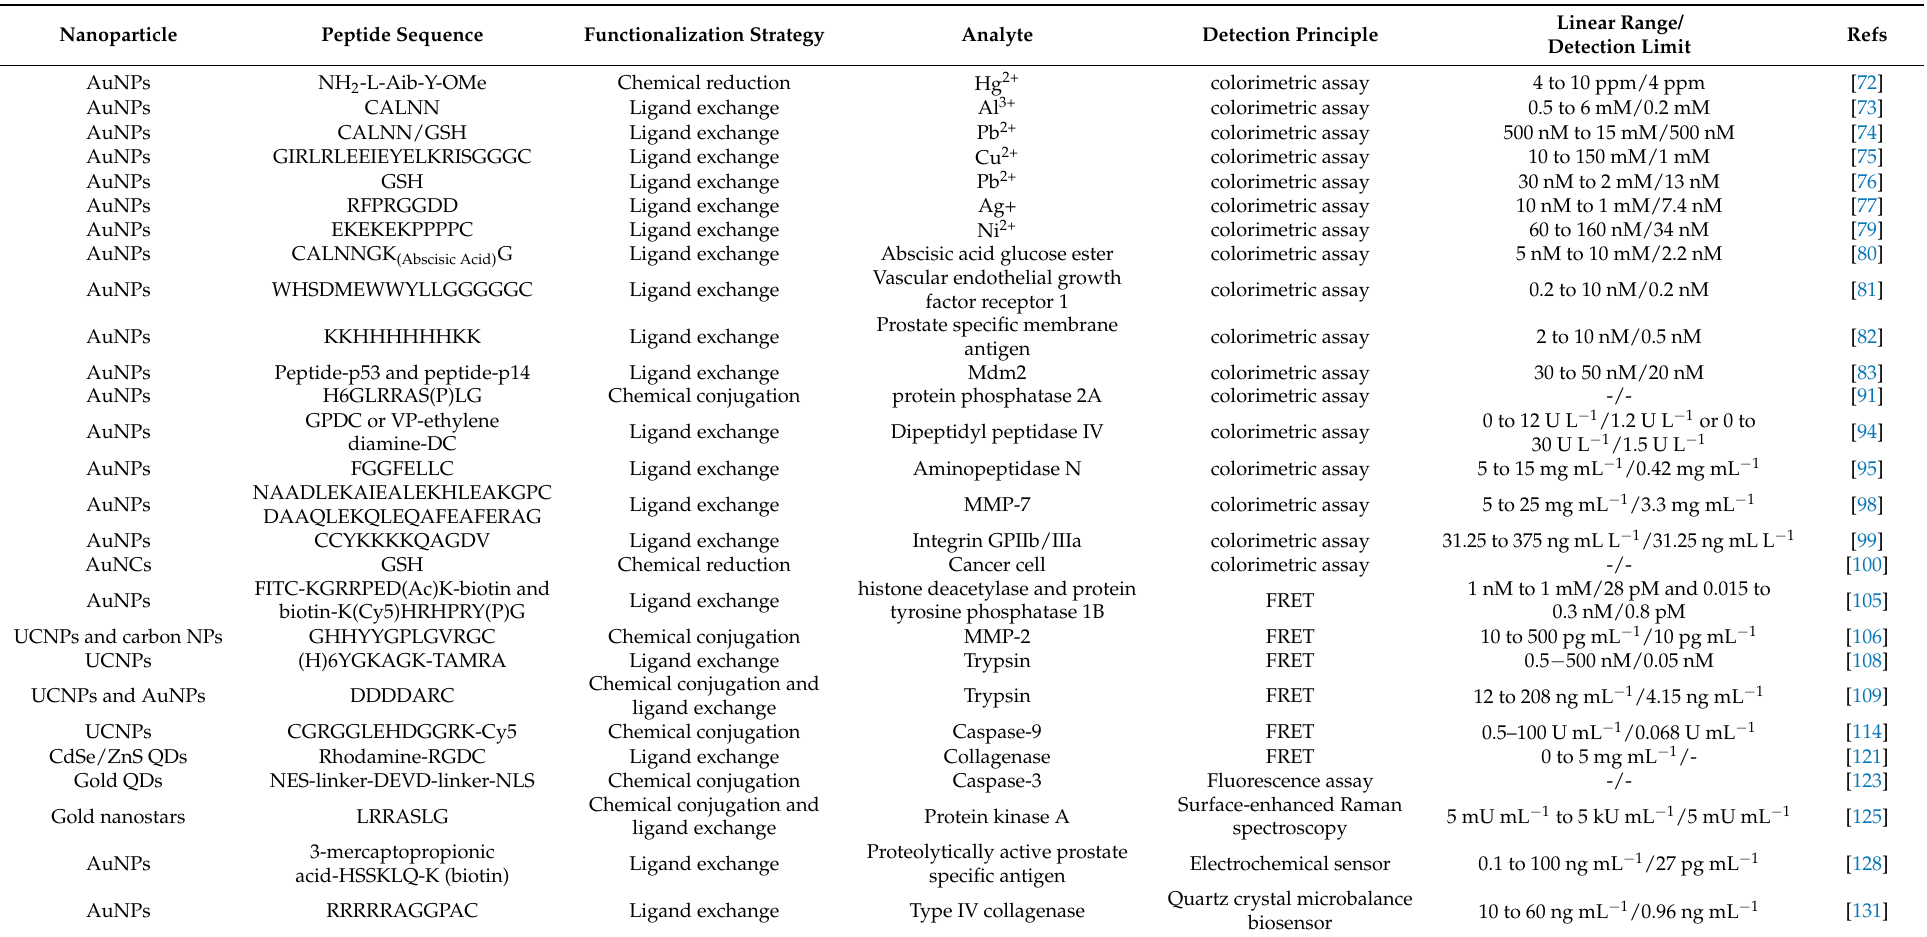
Table 1. Peptide functionalized NP-based biosensors/assays with various detection principles for detection of different analytes. Normally, the peptide functionalized AuNPs were used to developed colorimetric assays, while peptide functionalized fluorescence NPs, such as UCNPs and QDs, were used to construct fluorescence sensing